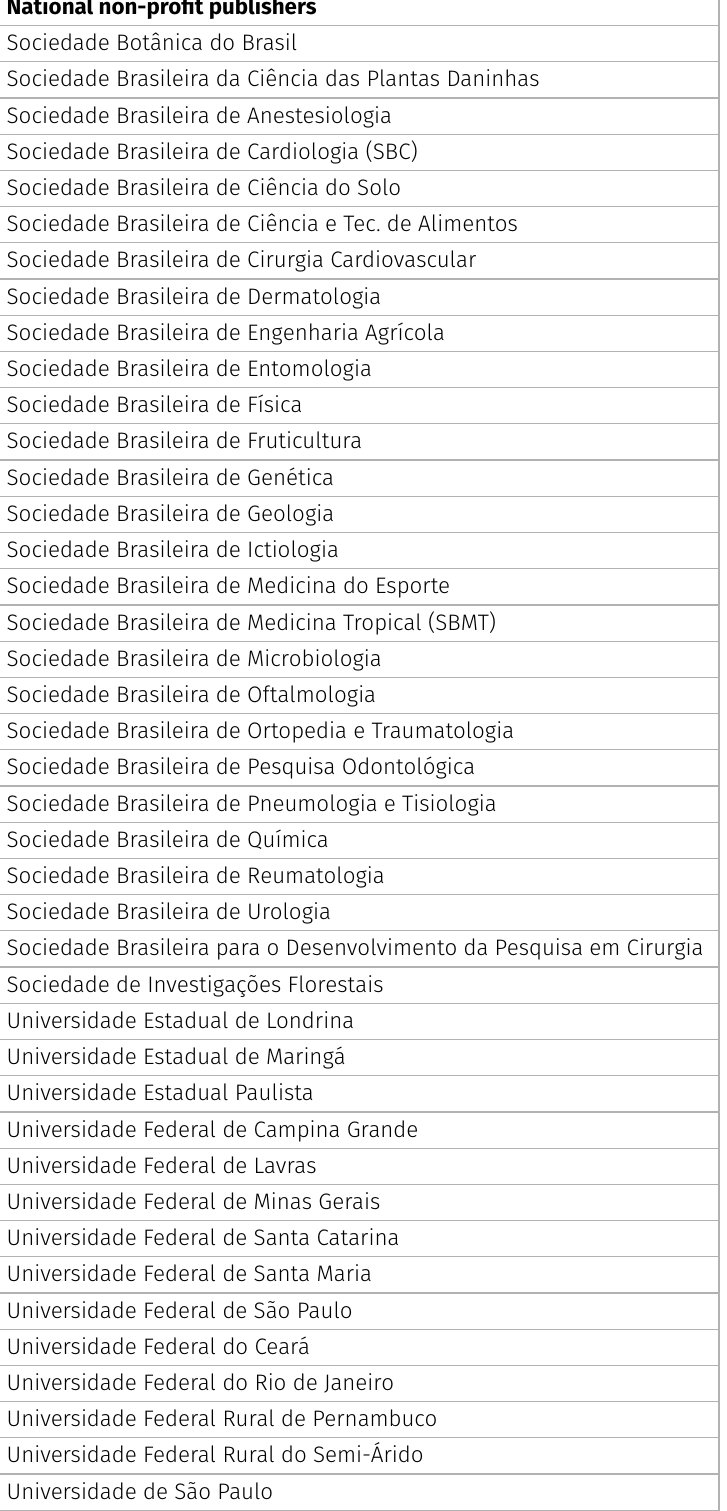
Table IV. National non-profit publishers considered in the survey. (Web of Science